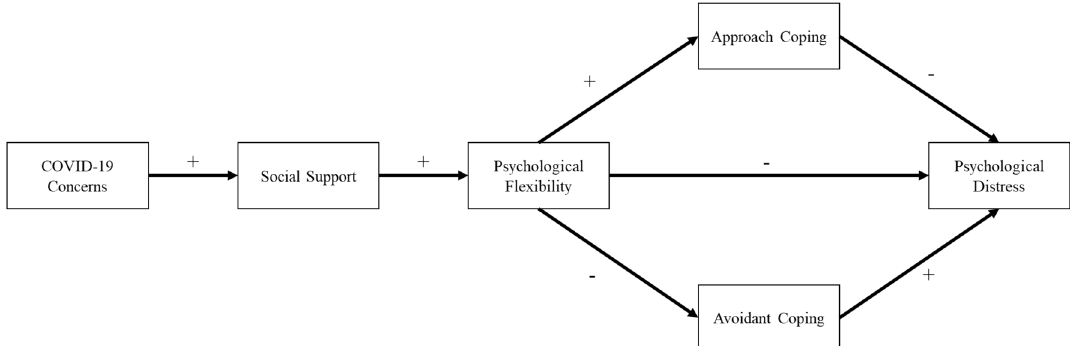
Figure 1. The hypothesised model to identify the pathway from COVID-19 concerns and psychological distress through social support, psychological flexibility, approach coping, and avoidant coping. Positive and negative signs indicated the predicted association between each